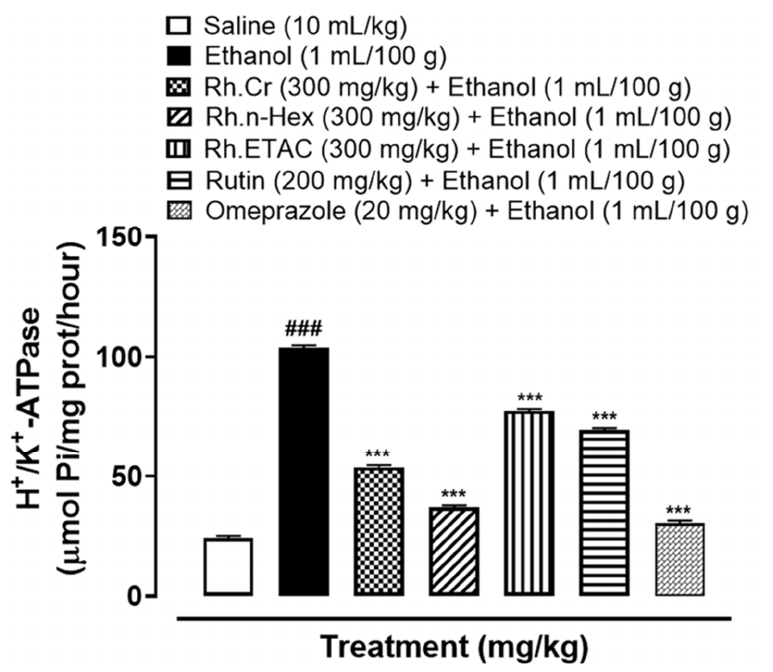
Figure 6. Effect of Rumex hastatus crude extract (Rh.Cr), n-hexane (Rh.n-Hex), ethyl acetate (Rh.ETAC) fraction, rutin and omeprazole against H + /K + -ATPase in ethanol-treated rats gastric tissues. Values are expressed as mean ± SEM ( n = 3). One-way ANOVA with post-hoc Tukey’s test. ### p < 0.001 vs. saline group, *** p < 0.001 vs. ethanol group.